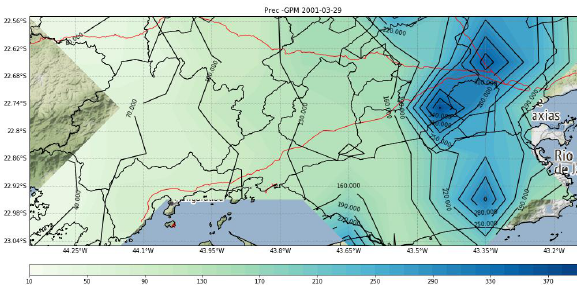
Figure 5. Accumulated daily rainfall shown as shaded and black contour lines with red lines representing pipeline transmissions.